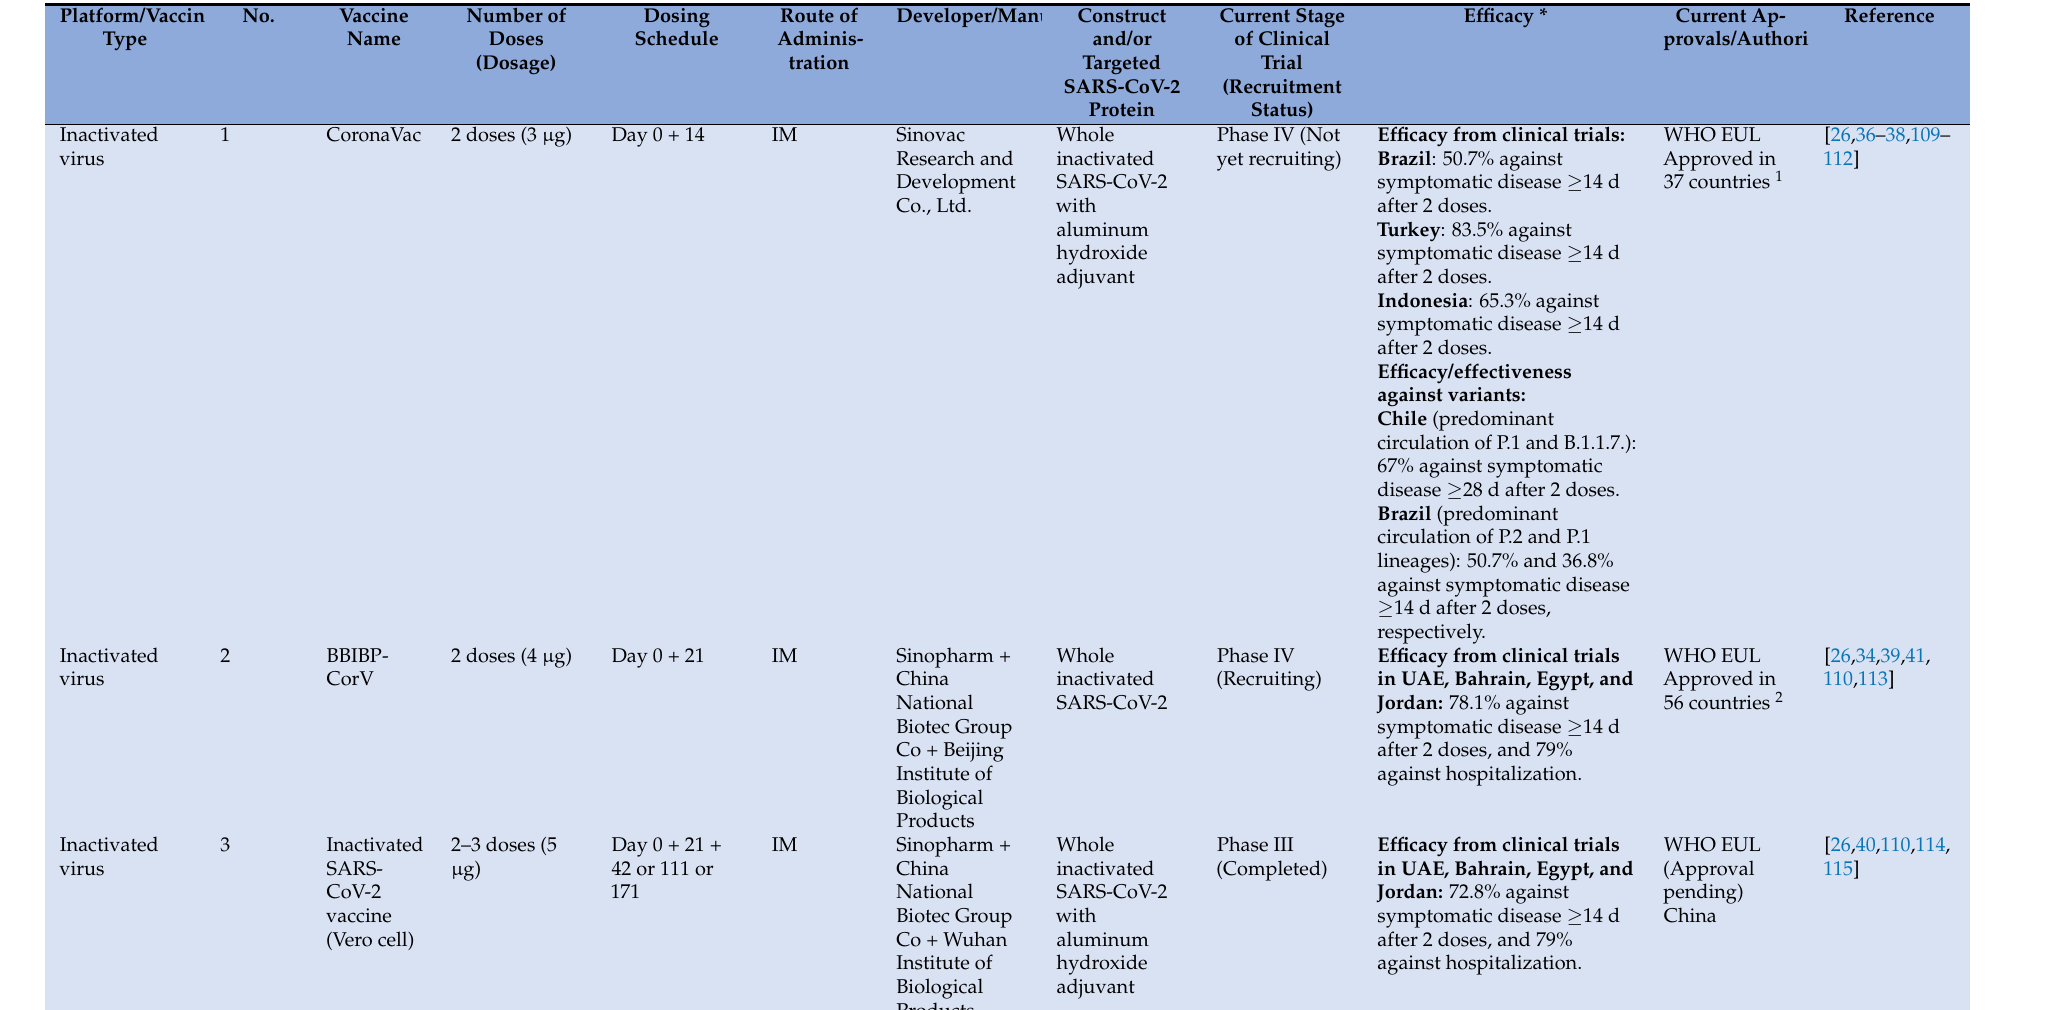
Table 1. SARS-CoV-2 Vaccine Candidates in Clinical Development